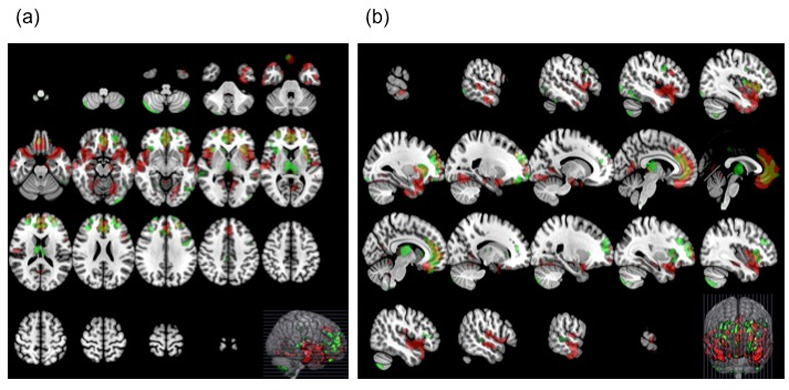
Regions with significant (FDR q <0.05 and cluster size of more than 100 voxels) weight values for both SVM models and their overlap.Regions in red represent area for the Nagoya University model, in green represent the Toyama University mode and yellow represent the overlap. Axial image (a) and sagittal image (b) (radiological convention).